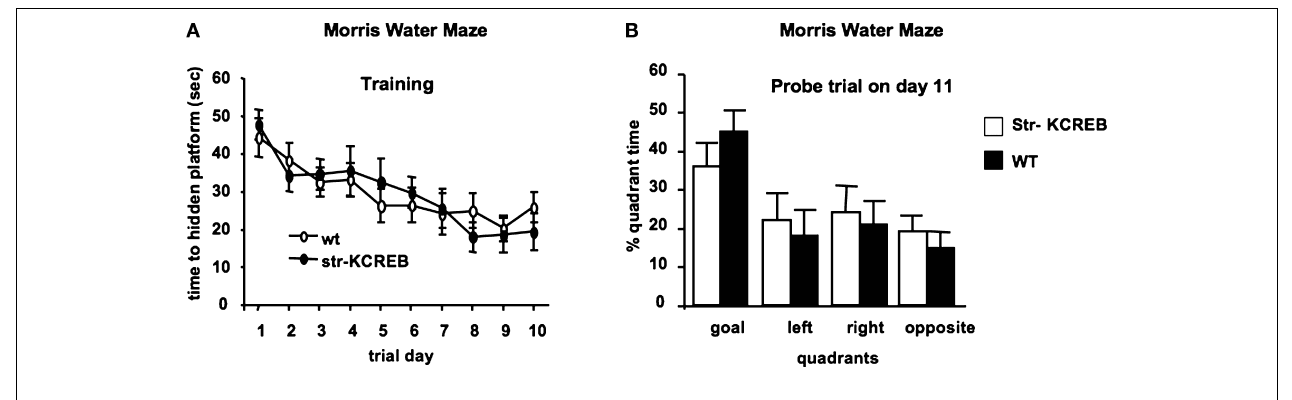
FIGURE 6 | Normal spatial memory in Morris water maze in str-KCREB mice. Animals were trained in the hidden-platform Morris water maze for 10 consecutive days (four trials/day; 20 min ITI) and then tested with a probe trial on day 11. (A) str-KCREB mice showed normal acquisition curve during the training days. ANOVA for repeated measures, revealed main effect of day P < 0.001, no effect of genotype